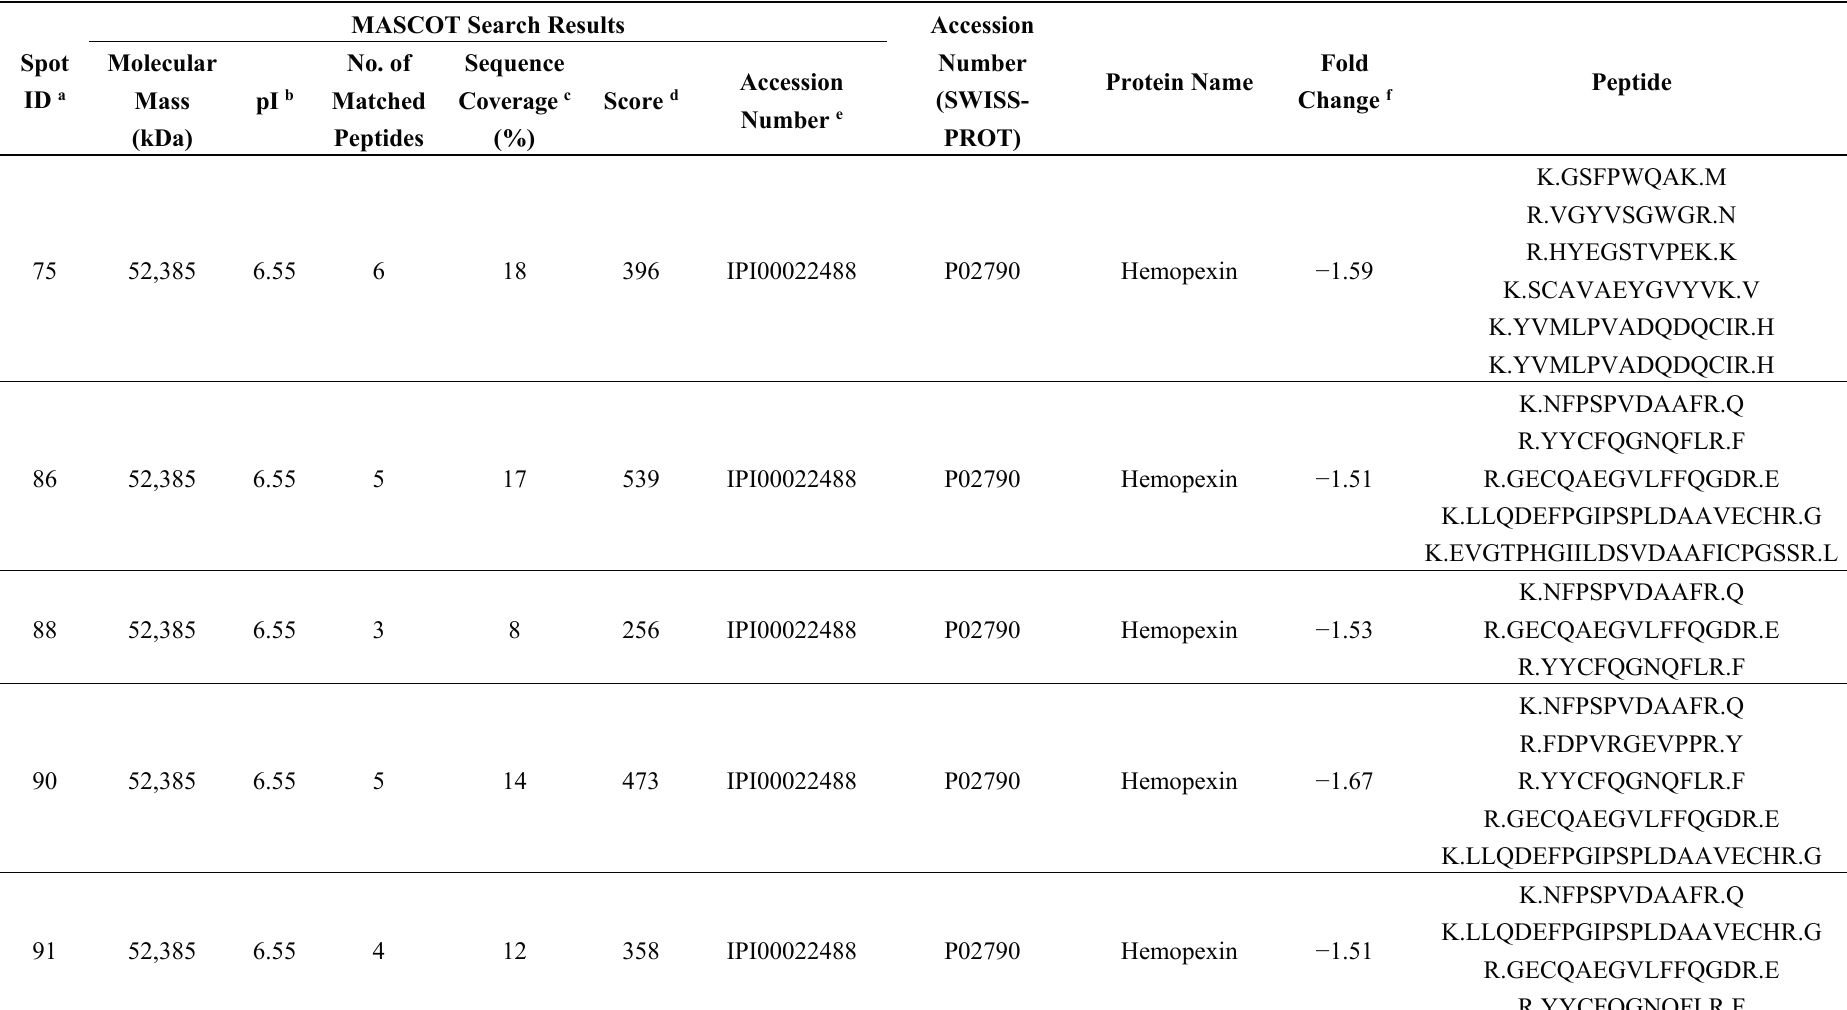
Table 2. Proteins identified using MALDI-TOF-TOF mass